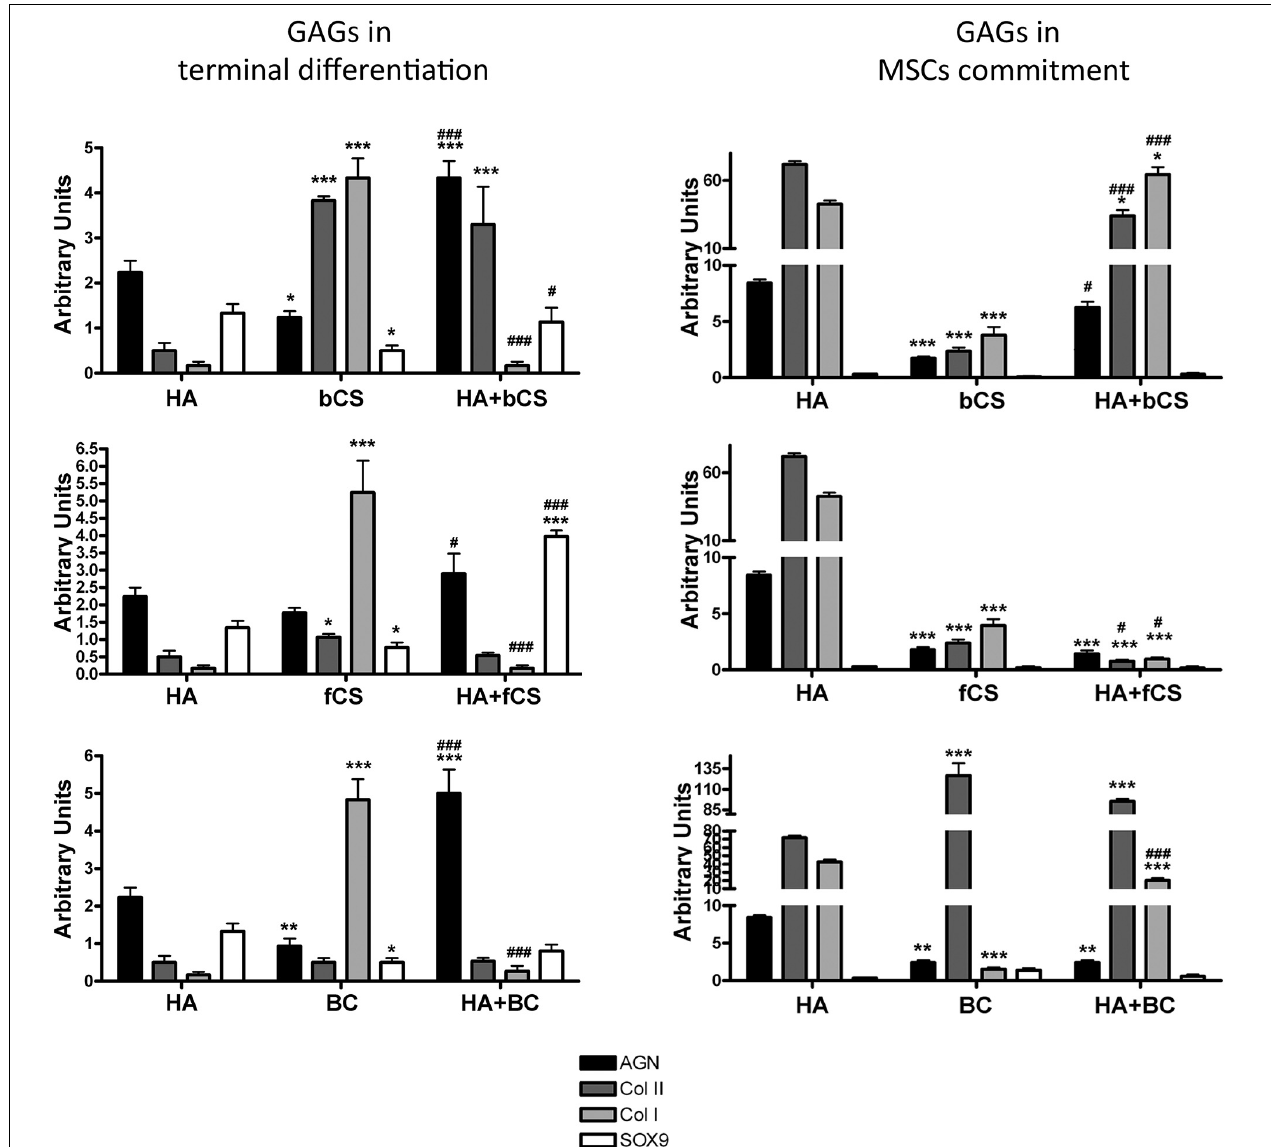
FIGURE 2 | Chondrocyte differentiation markers in several experimental conditions. The picture shows the mRNA levels of aggrecan (AGN), Type I collagen (Col I), Type II collagen (Col II), and SOX9 in MSCs induced to chondrocyte differentiation with GAGs in terminal differentiation and GAGs in MSC commitment, respectively. Data are normalized to mRNA levels observed in differentiated cultures obtained with the Reference Method. For each mRNA, the expression level observed in reference cultures is set at 1, its decrease or increase in the other experimental conditions is expressed as fold change. Data are reported with standard deviation ( n = 3). We compared the gene expression in HA hydrogel with the HA + bCS hydrogel. In each histogram the symbol * indicates the statistical difference between them. We compared the gene expression in bCS hydrogel with the HA + bCS hydrogel. In each histogram the symbol # indicates the statistical difference between them (* < 0.05; ** < 0.01; *** < 0.001; # < 0.05; ## < 0.01; ### <